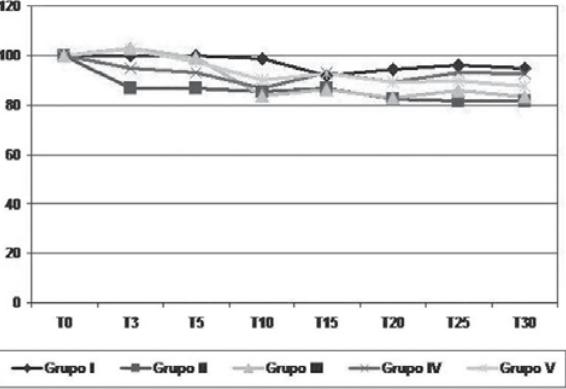
Fig. 3 - Variação percentual da freqüência cardíaca em batimentos por minuto, dentro dos períodos estudados em cada grupo